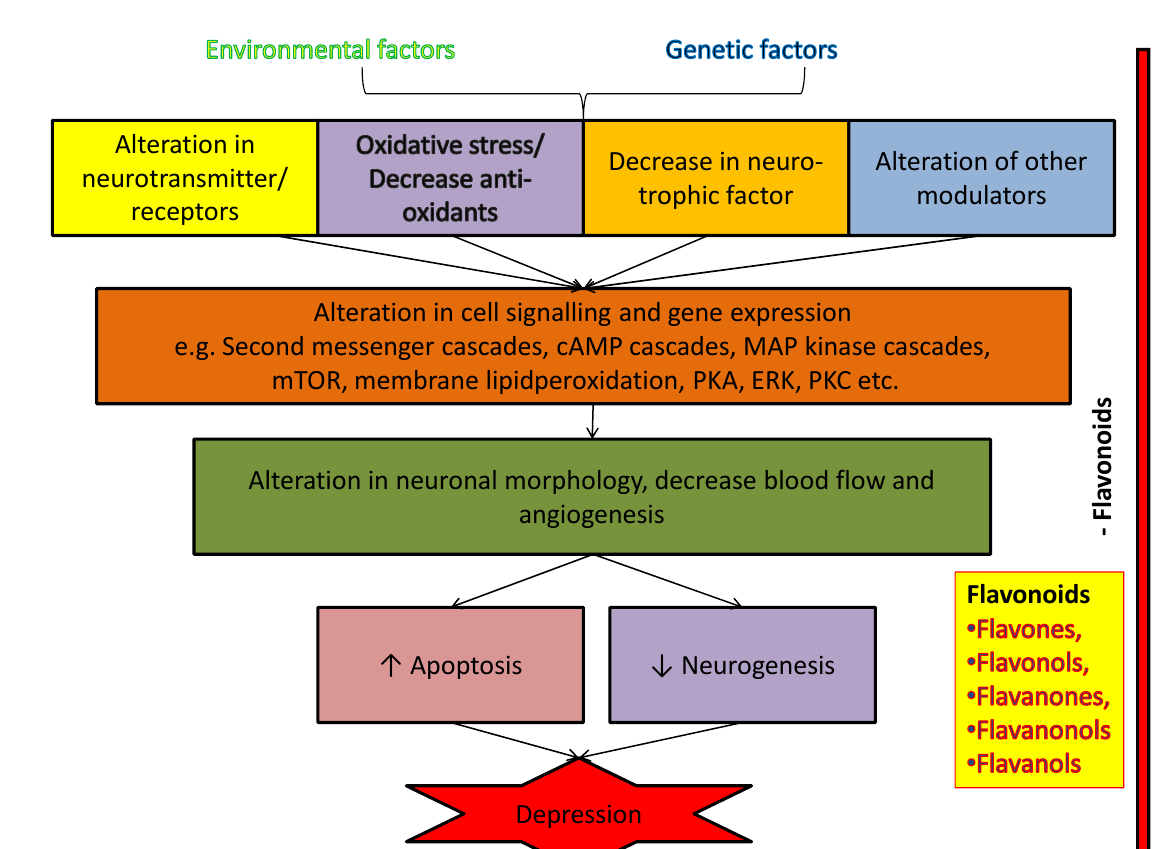
Figure 46. Possible anti-depressant mechanisms of flavonoids. cAMP, cyclic adenosine monophosphate; MAP, mitogen- activated protein; mTOR, mammalian target of rapamycin; PKA, protein kinase A; ERK, extracellular regulated kinase; PKC, protein kinase C.